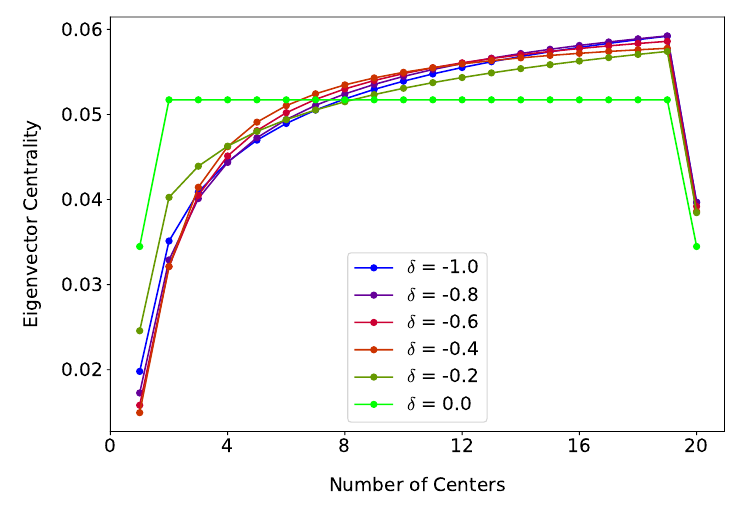
Figure 10: The eigenvector centrality for different values of δ when β = 0, γ = 1, = 20. and N max